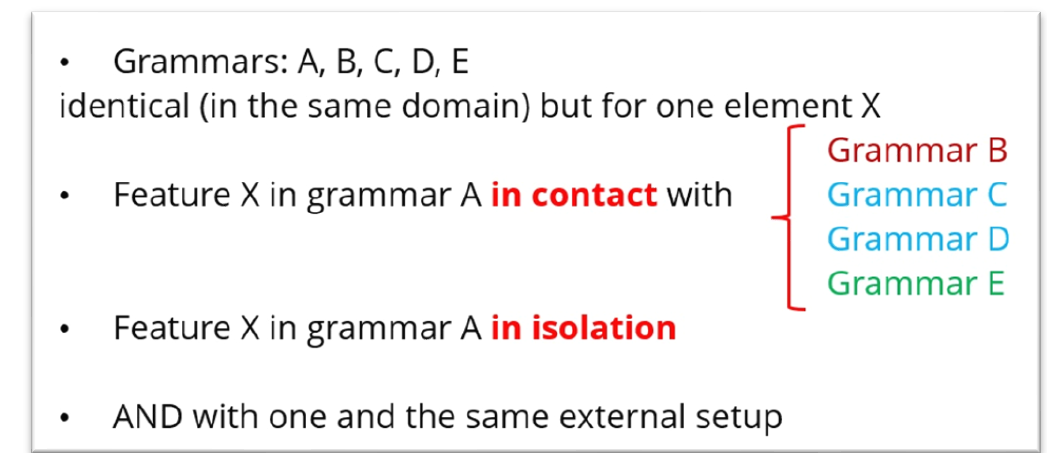
Figure 2 Microcontact